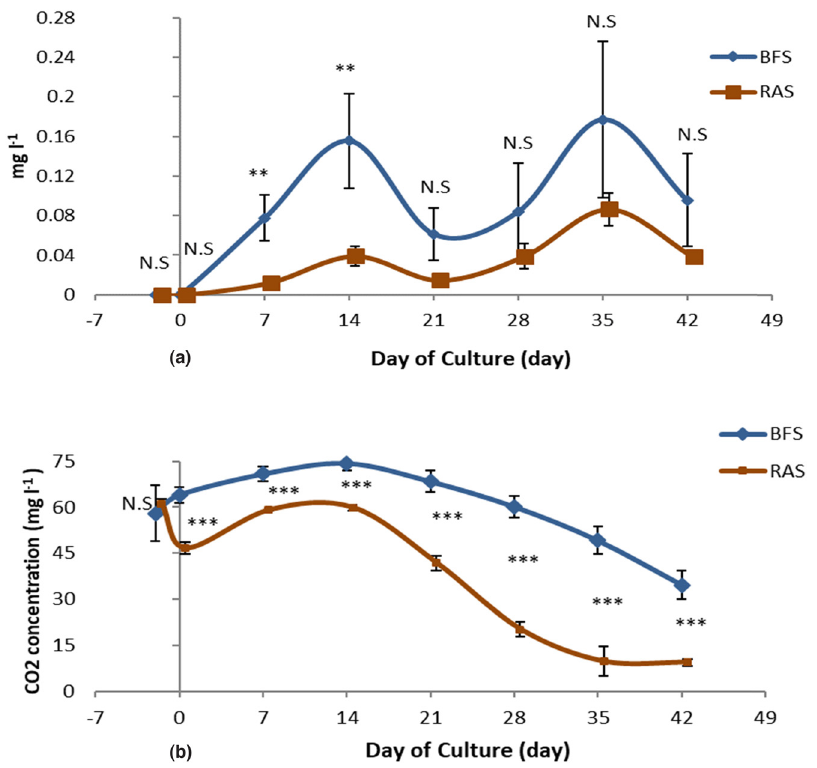
Figure 4: Concentration of urea and CO 2 in the rearing water of RAS and BFS. ( a ) Mean urea (± SD ) concentrations in the rearing water of RAS and BFS on sampling dates ( N.S. means not signi fi cantly di ff erent ( p > 0.05 )) ; ** mean signi fi cant di ff erence at p < 0.01; *** – p < 0.001. ( b ) Carbon dioxide concentrations ( mean ± SD ) in RAS and BFS on sampling dates; ** means signi fi cant di ff erence at p < 0.05; *** – p <